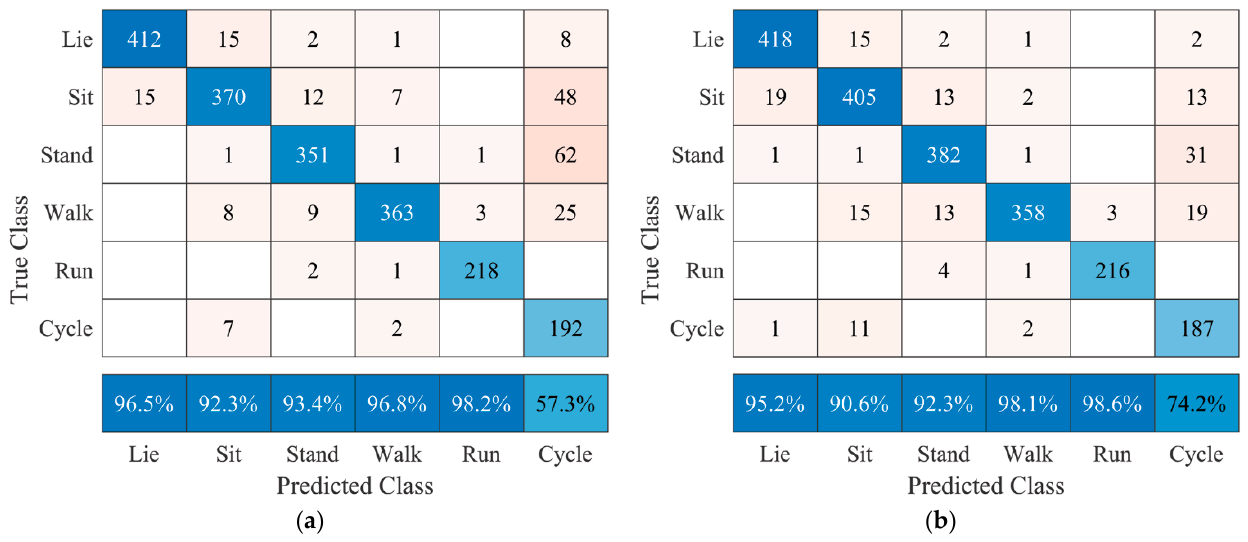
Figure 6. Confusion matrices after testing user-specific models using several sensor combinations of all seven subjects. ( a ) sensors 1 and 2 (accuracy 89.2%); ( b ) sensors 1,2, and 3 (accuracy 90.0%). The bottom row represents the positive predictive values for each posture or movement. Table 6. Classification results for different sensor combinations when assessing model perfor- mance using varying sensor placements after training the model based on the data of sensor loca- tion 3. Shown are mean accuracies (%) and the corresponding standard deviation of all seven sub- jects when developing user-specific or generalized models.